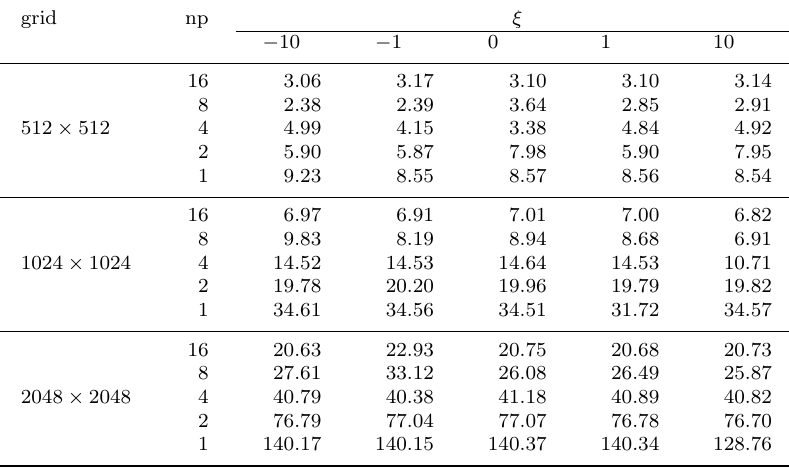
Table 5. Computation time in seconds for